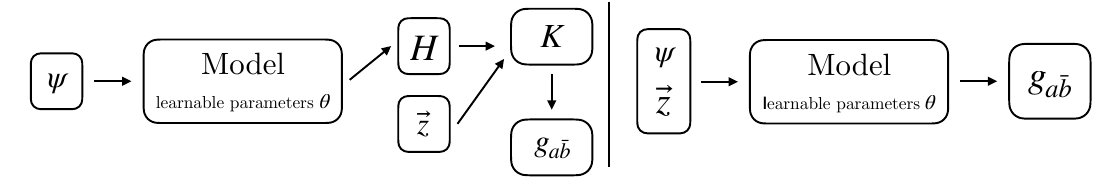
Figure 1 . Schematic overview of how models predicting the Hermitian matrix H ( left ) and the metric g ( right ) are designed. The respective models are neural networks of different a ¯ b